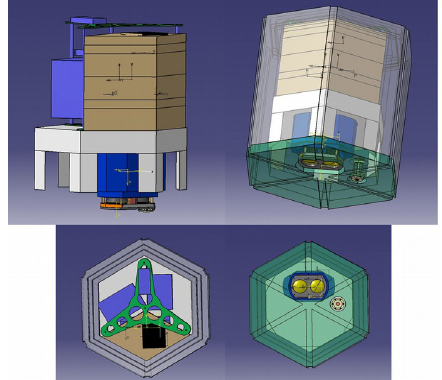
Fig. 1 3D drawing of the BeCOOL microlidar in the STRAT configuration gondola. The insulated hexagonal shaped boxes used to contain parts of the instrument are shown in brown. They are located in the same volume as the batteries and other instruments. The telescope with its two lenses can be seen in the lower “cold” volume of the